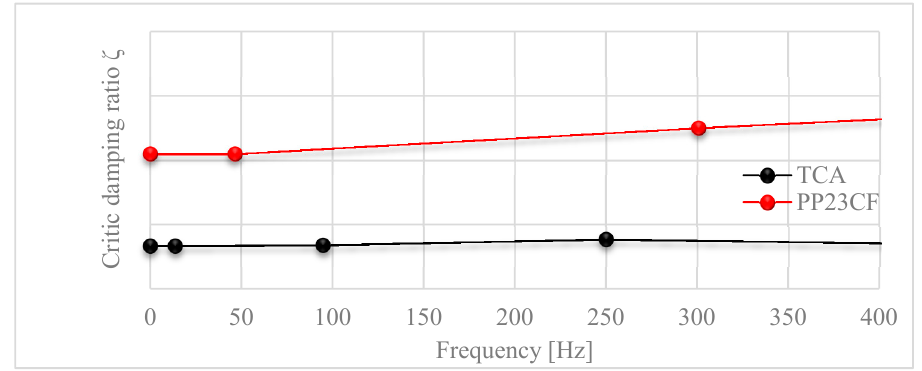
Figure 10. Critical damping of two different materials analyzed: Composite with glass fibers (TCA) and composite with vegetable fibers (PP23CF).